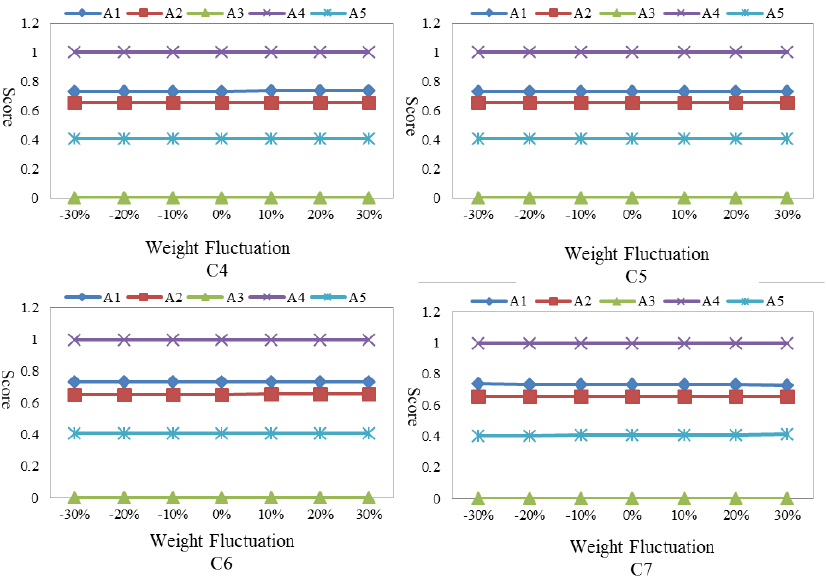
Figure 6. Sensitivity analysis results of the sub-criteria in the society group.